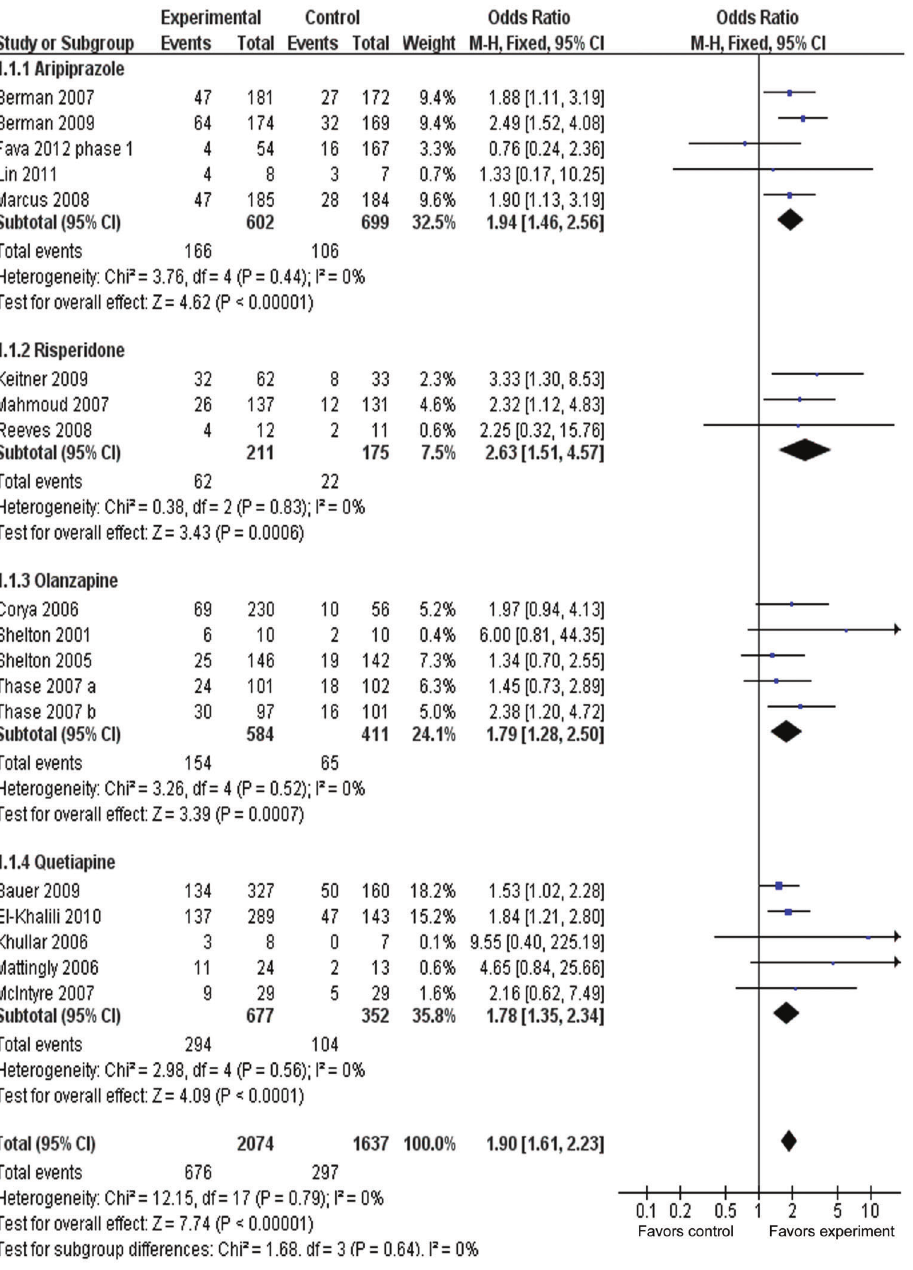
Figure 3. Meta-analysis of remission rates of adjunctive atypical antipsychotics in major depressive disorder. Odds ratios for remission on drug and placebo are grouped by types of atypical antipsychotics. Thase et al. (29) contains two identical trials. All trials were included in this subgroup